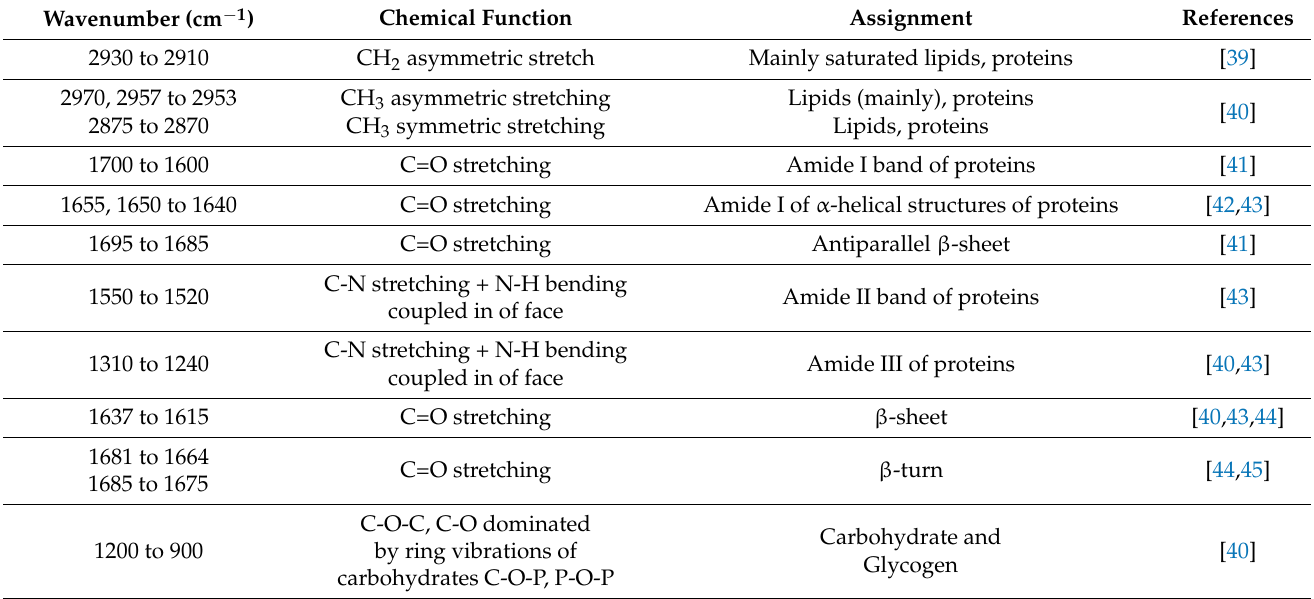
Table 2. Relationship between molecular functional group and